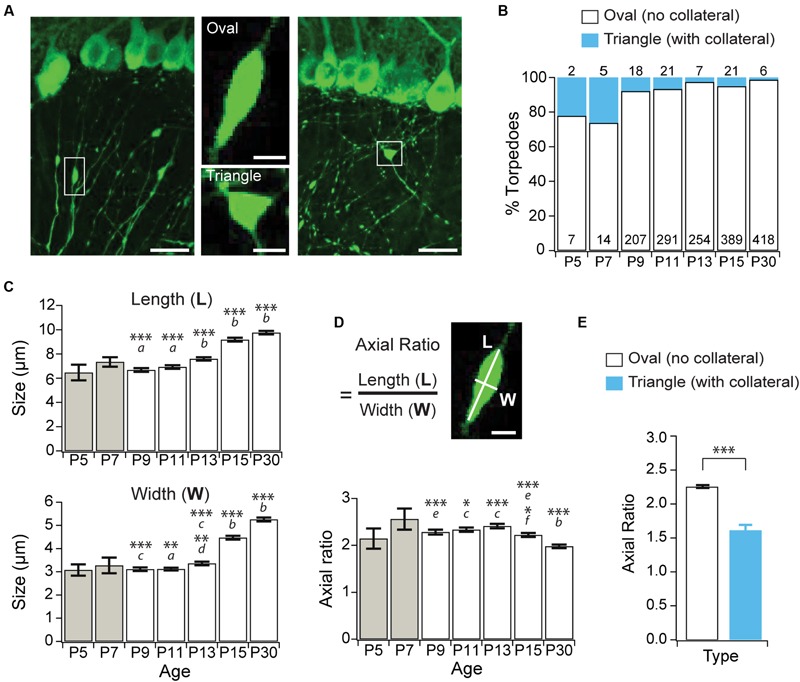
Purkinje cell developmental torpedoes are seldom associated with axonal branch points. (A) Left: sample image showing oval-shaped axonal torpedo (inset, middle top); and right: triangle-shaped torpedo associated with axonal collateral branch point (inset, middle bottom). Scale bar for left and right images, 20 μm; scale bar for insets in middle, 5 μm. (B) The majority of torpedoes are not associated with collateral branch points (white bars), with only a subset associated with collaterals (blue bars) at all ages. Number of torpedoes counted indicated in (white) or above (cyan) bars. (C) Torpedo length (top) and width (bottom) increased after P13. (D) The axial ratio (length, L/width, W) significantly decreased at P15 and P30 because torpedo width increased more than length at these ages. Scale bar, 5 μm. (E) The axial ratio is significantly lower in triangle torpedoes associated with axon collateral branch points than in oval-shaped torpedoes that are not associated with branch points. Note that because there are so few torpedoes at P5 and P7 (B), these ages were not included in the analysis in panels (C,D). They are included in the graph for reference (gray bars). Significance determined by Wilcoxon multiple comparisons followed by Benjamini–Hochberg procedure with the FDR = 0.05 for panels (C,D), and with a Mann–Whitney U test for panel (E). Asterisks denote the minimum significance for comparisons where the letter denotes the relevant comparisons: a = significantly different from P13, P15, and P30; b = significantly different from all other ages; c = significantly different from P15, and P30; d = significantly different from P11; e = significantly different from P30. f = significantly different from P11 and P13. All comparisons that are non-indicated are not significantly different, P > 0.05. ∗P < 0.05, ∗∗P < 0.01; ∗∗∗P < 0.001.